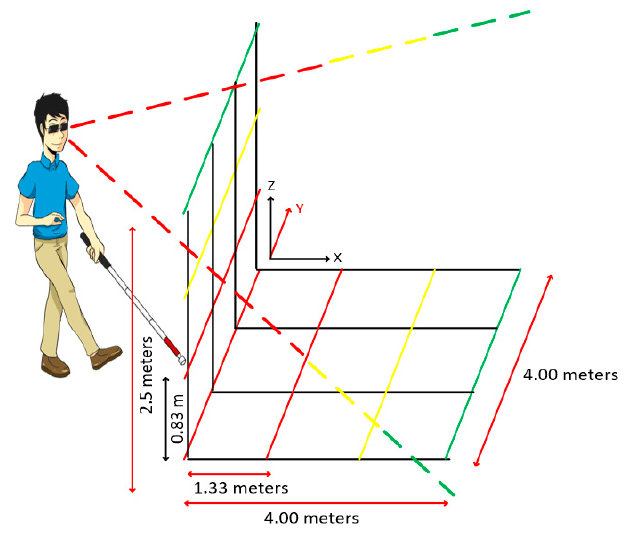
Figure 8. Obstacle detection scheme using stereo vision.